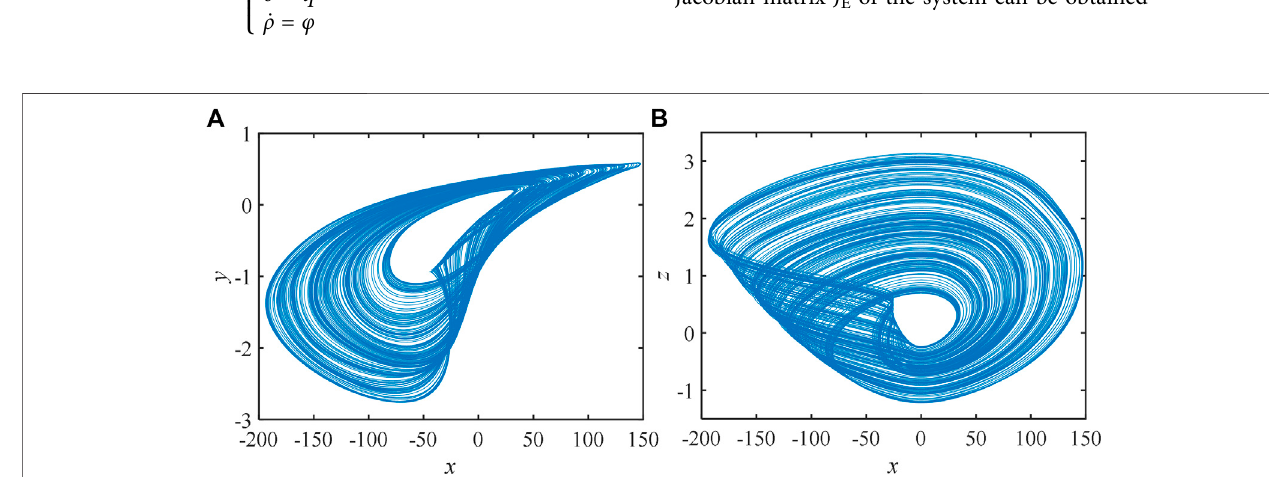
FIGURE 5 | Phase diagram (A) x – y plane (B) x – z